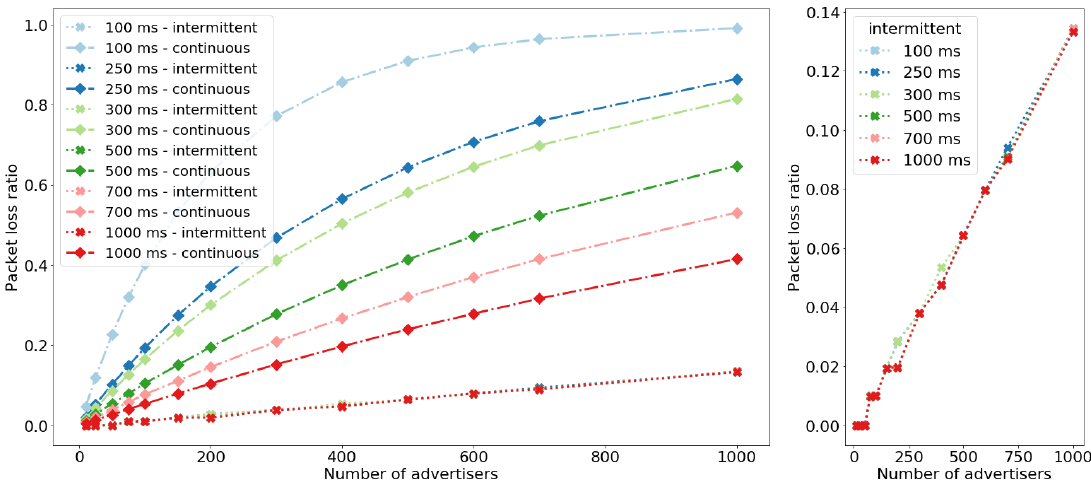
Figure 6. Median of the Packet Loss Ratio for continuous and intermittent operation of the networks composed of various number of nodes. Different colours denote different advertisement intervals and operation modes. The plot on the right shows result for intermittent mode only as the PLR is significantly lower compared to continuous mode.